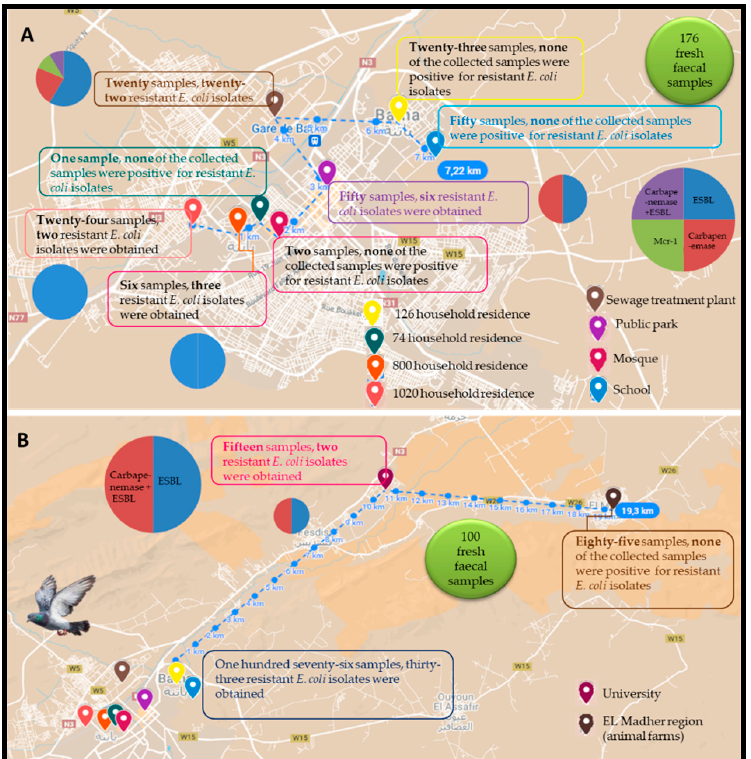
Figure 1. Location of sampling points with the detection rate of AMR E. coli in the different sites targeted in this study. ( A ) 176 fresh faecal samples; ( B ) 100 fresh faecal samples.